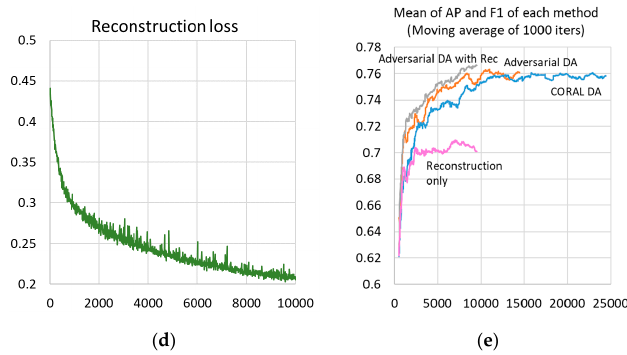
Figure 9. Training and validation curves of each DA method: ( a ) CORAL DA loss, ( b ) adversarial DA loss, ( c ) reconstruction loss in Adversarial DA with reconstruction, ( d ) reconstruction loss in the reconstruction-only method, ( e ) validation accuracy (1000 iterations moving average of mean of average precision (AP) and F1 measure (F1)) of each DA method. Best viewed in color. The black, purple, yellow, red, green, gray, orange, blue, and pink lines represent CORAL loss, SSD loss, extractor loss, discriminator loss, reconstruction loss, scores of mean of AP and F1 in adversarial DA with reconstruction, adversarial DA, CORAL DA, and reconstruction only, respectively.